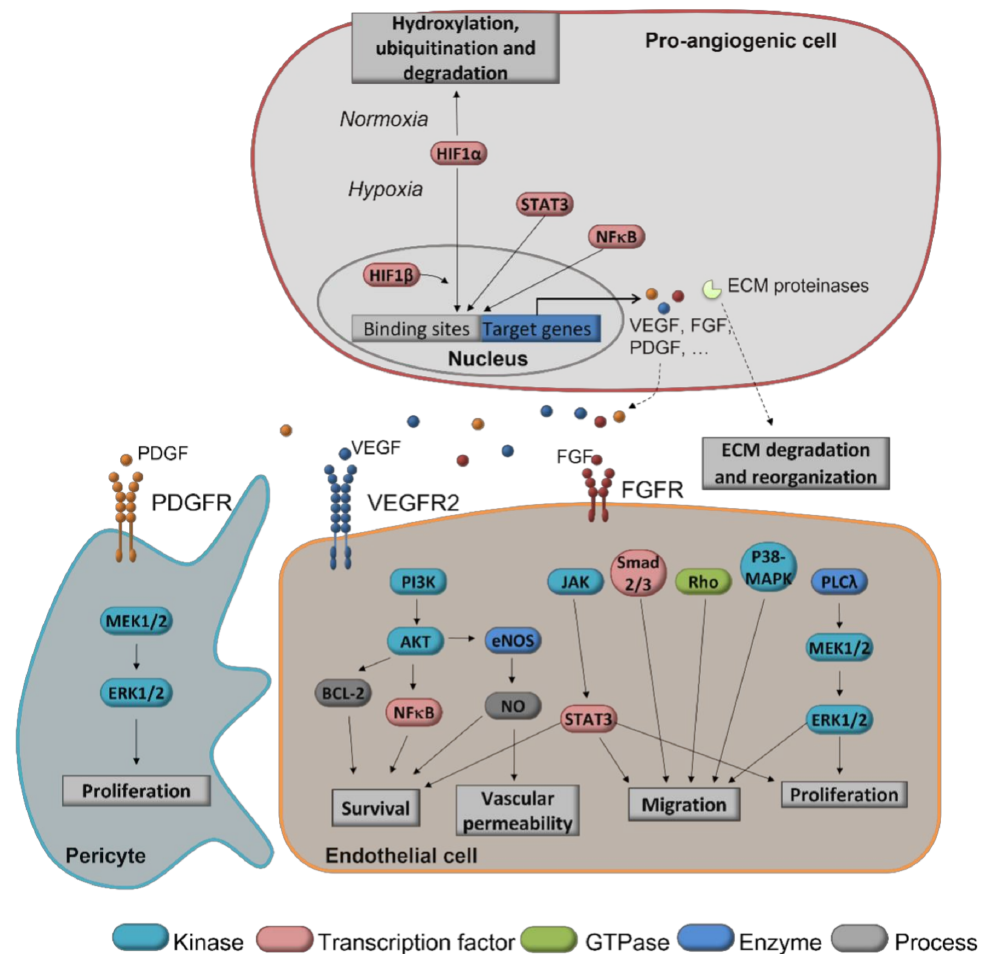
Figure 4. Summary of some of the most important signaling pathways, molecules, and processes involved in the angiogenic process. Proangiogenic cells (i.e., cancer cells) are a source of proangiogenic molecules, such as growth factors, for example, VEGF; cytokines; and ECM-degrading proteases, such as MMPs, that can be received by endothelial cells and pericytes, activating their differentiation, proliferation, survival, and migration to form new vessels. The proteases released by proangiogenic cells degrade the ECM to allow the migration of endothelial cells, releasing as well proangiogenic factors from ECM elements [41–44]. HIF-1 α / β : hypoxia-inducible factor 1-alpha/beta; STAT3: signal transducer and activator of transcription 3; NF- κ B: nuclear factor kappa-light-chain-enhancer of activated B cells; VEGF(R): vascular endothelial growth factor (receptor); FGF(R): fibroblast growth factor (receptor); PDGF(R): platelet-derived growth factor (receptor); MEK1/2: mitogen-activated protein kinase kinase 1/2; ERK1/2: extracellular signal-regulated kinase 1/2; PI3K: phosphoinositide 3 kinase; eNOS: endothelial nitric oxide synthase; NO: nitric oxide; BCL-2: B-cell leukemia/lymphoma 2; JAK: Janus tyrosine kinase; Smad 2/3: mothers against decapentaplegic homolog 2; P38-MAPK: 38-kDa mitogen-activated protein kinase; PLC λ : phospholipase C- λ